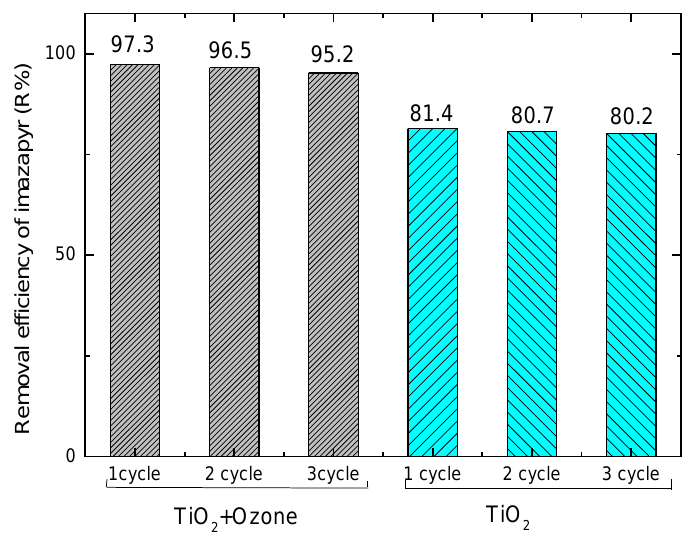
Figure 10. Catalytic recycling Of TiO 2 (at the presence of ozone & without) in Imazapyr degradation, stirring speed = 1000 min − 1 , m TiO 2 = 50 mg). Aqueous suspension Milli-Q water.